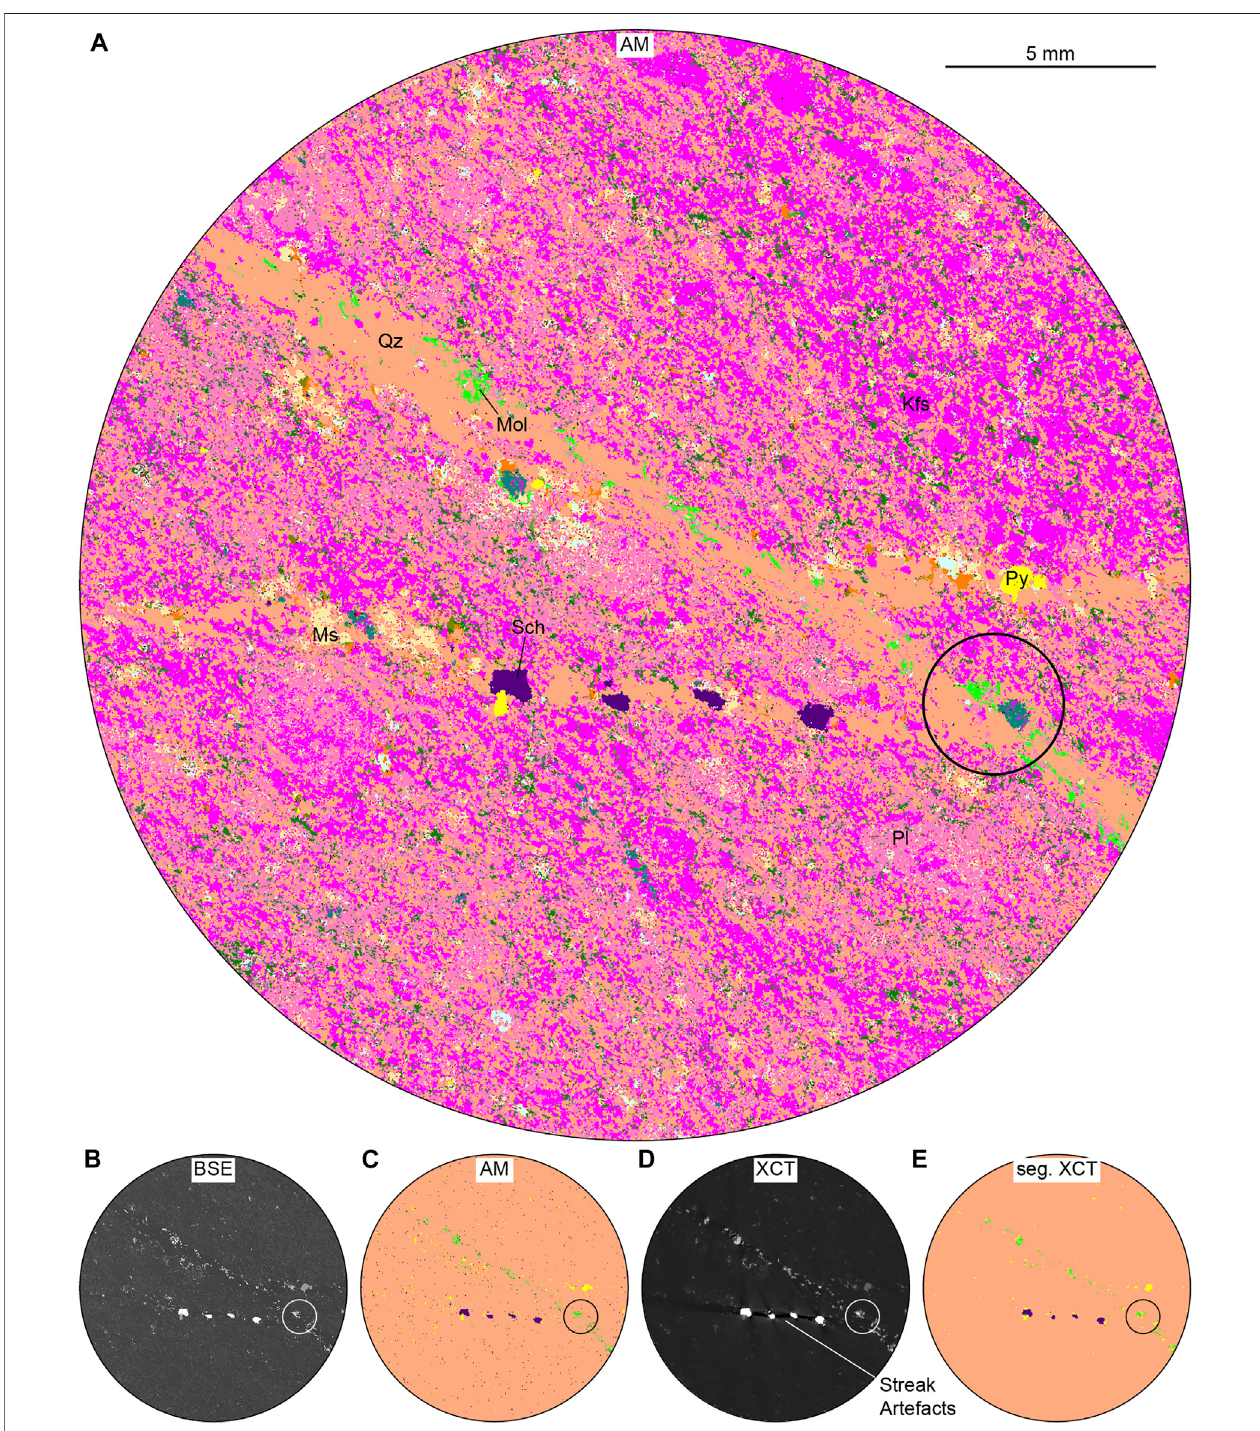
FIGURE7| AMand XCTimages ofapolished rock chipofscheelite- and molybdenite-mineralized quartzveins inanaplitedyke (sample3). Forcolorcodingofthe minerals, see Table2 . (A) 30 μ mpixelsizeAMmineralmap.Theblackcircleindicates theoverlappingregionbetweenthe1 μ mpixelsizeAMmineralmapand the4 μ m voxel sizeXCT scan (see Figure 9 ). (B) 1.87 μ m pixelsize AM BSE image. (C) 30 μ m pixel sizesimpli fi ed AM mineral map. (D) 30 μ m voxel sizeXCT scan. The scheelite grains cause some streak artefacts. (E) 30 μ m voxel size segmented XCT scan. Some of the silicates/carbonates in contact with scheelite are segmented as sul fi des/oxides due to the streak artefacts but overall impact is minor. Abbreviations: Kfs – k-feldspar, Mol – molybdenite, Ms – muscovite, Pl – plagioclase, Py – pyrite, Sch – scheelite, Qz – quartz.